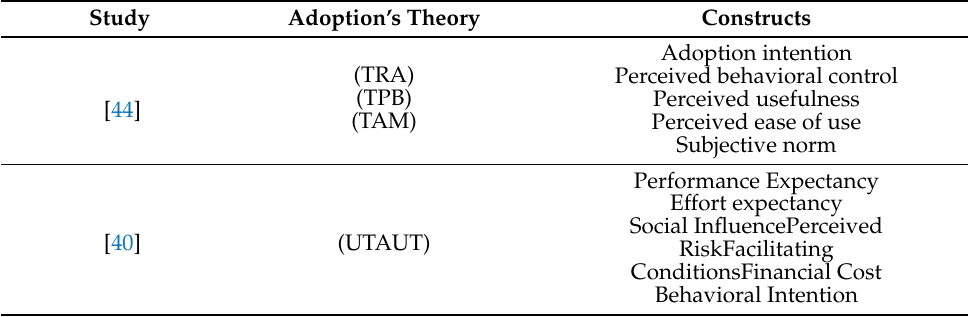
Figure 4. Number of Articles Published by Year. Table 3. The theories and their constructs that were used in each